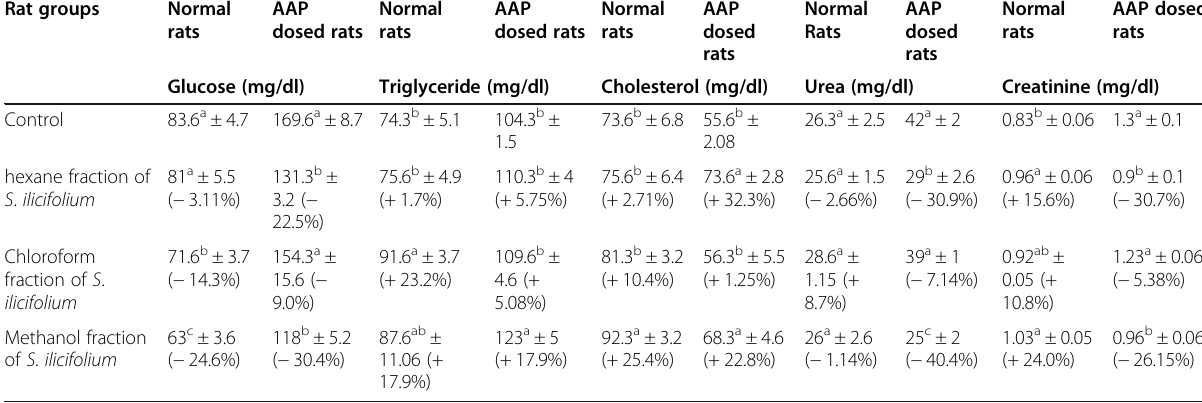
Table 2 Effect of n- hexane, chloroform and methanol soluble fractions of Sargassum ilicifolium on glucose, lipid parameters and kidney function markers in normal and acetaminophen dosed